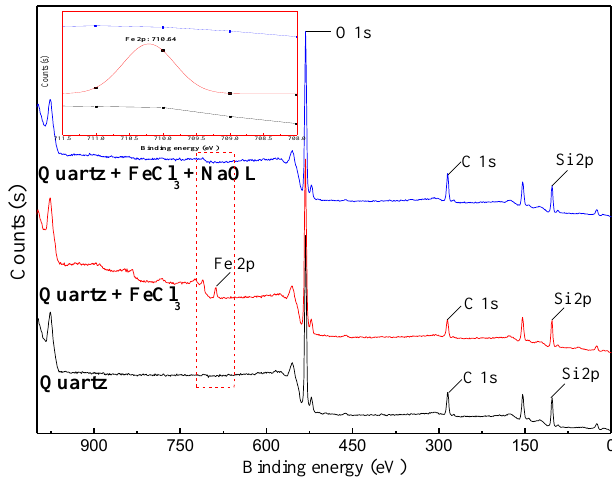
Figure 7. Binding energy of kyanite with and without regulator treatment.